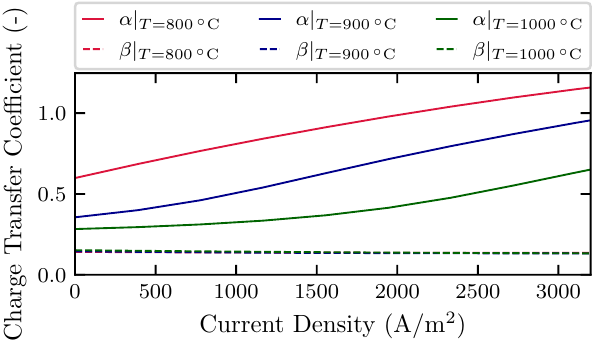
Figure 15. Charge transfer coefficients values proposed by the IMANN versus current